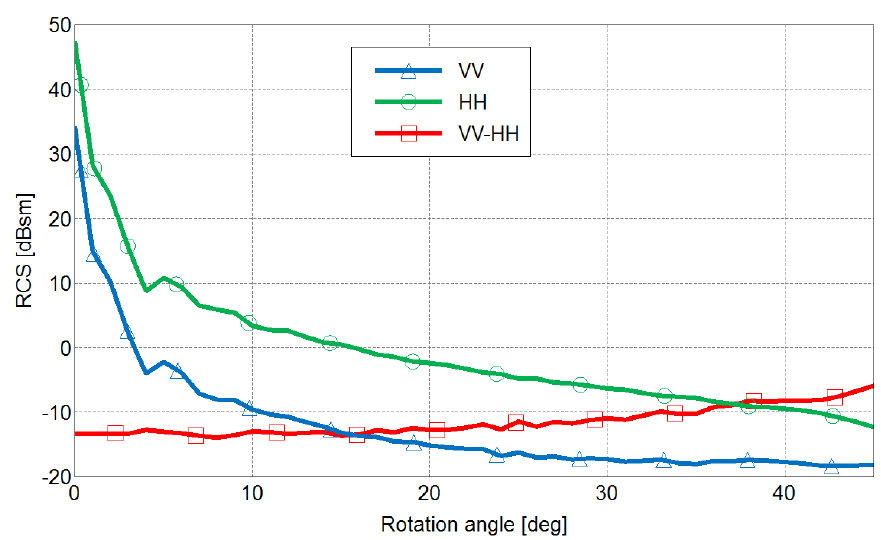
Figure 5. Variation of the backscattering coefficients σ 0 at VV (blue) and HH (green) for an orientation angle ψ ranging from 0 to 45 degrees. In red, the result of σ